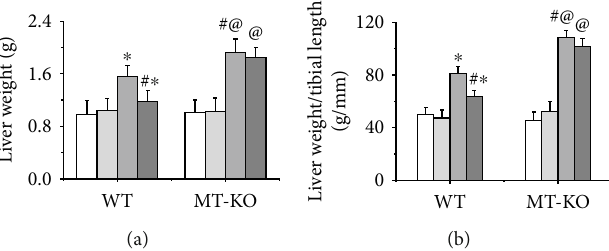
Figure 4: The e ff ect of zinc supplementation on type 2 diabetes-induced liver hypertrophy in both WT and MT-KO mice. The liver weight (a), especially the ratio of liver weight to tibia length (b), is the key judgment criterion to evaluate the liver hypertrophy which was measured in the present study. Data are presented as the mean ± standard deviation ( n = 8 /group). ∗ P < 0 : 05 vs. the control (Con) group in WT mice; # P < 0 : 05 vs. the type 2 diabetes (DM) group in WT mice; @ P < 0 : 05 vs. the control (Con) group in MT-KO